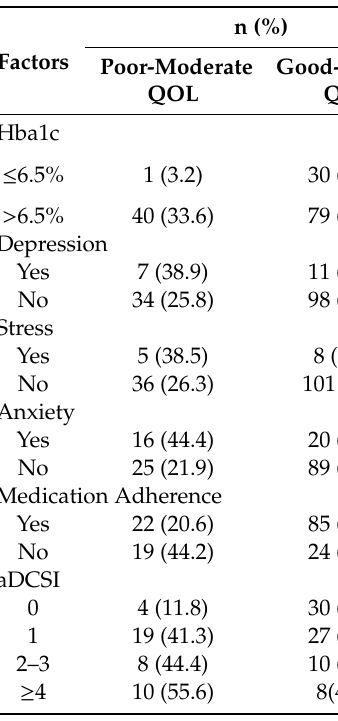
Table 3. Simple and multiple binary logistic regression analysis of factors associated with quality of life of study participants (n =